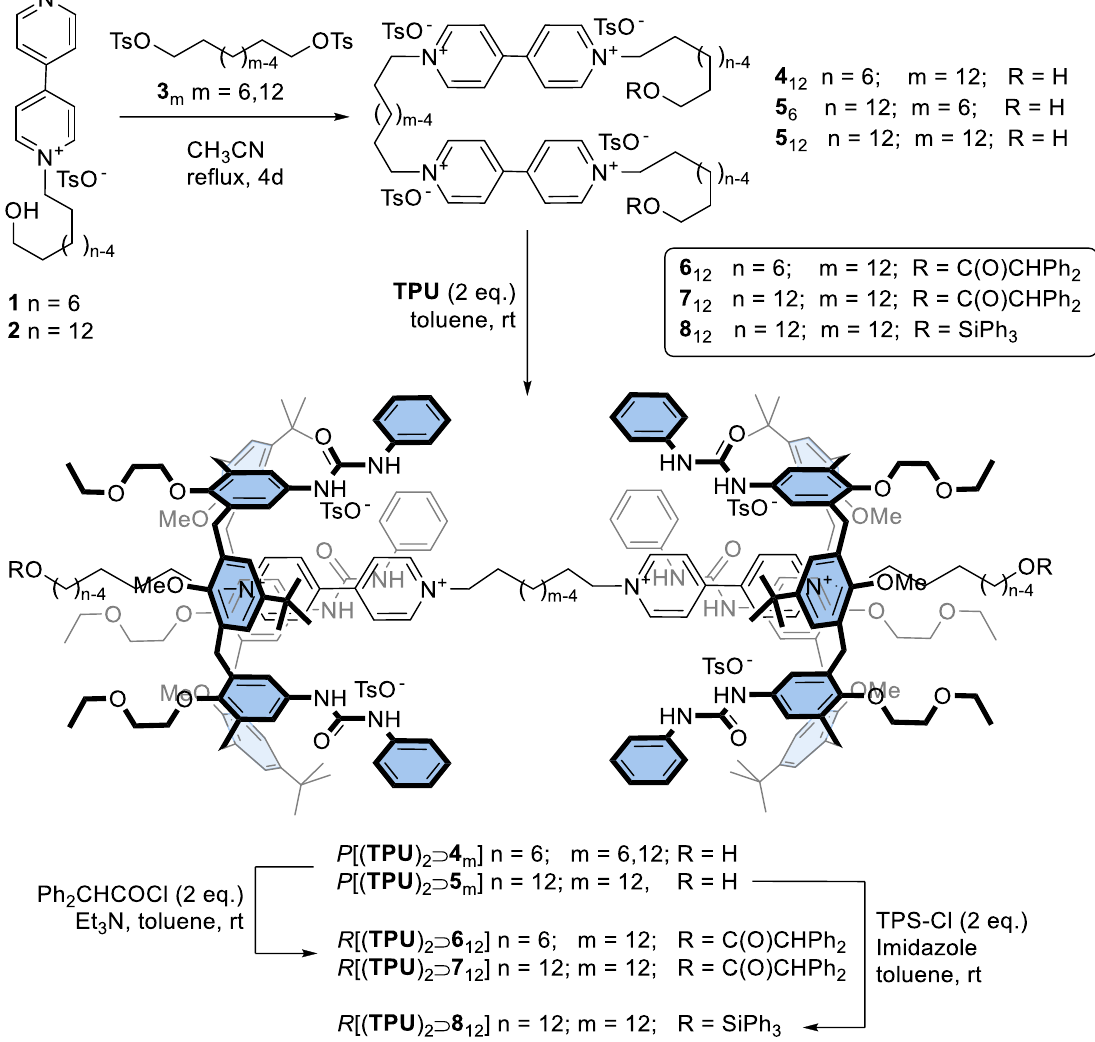
Figure 2 for the labelling) linked to the pyridinium moieties and a triplet at 3.53 ppm for the four protons of the two hydroxymethyl groups 1 . The two bipyridinium units resonate as two doublets, each integrating eight protons, at 9.22 (protons ¥ , # ) and 8.63 ppm ( $ , §